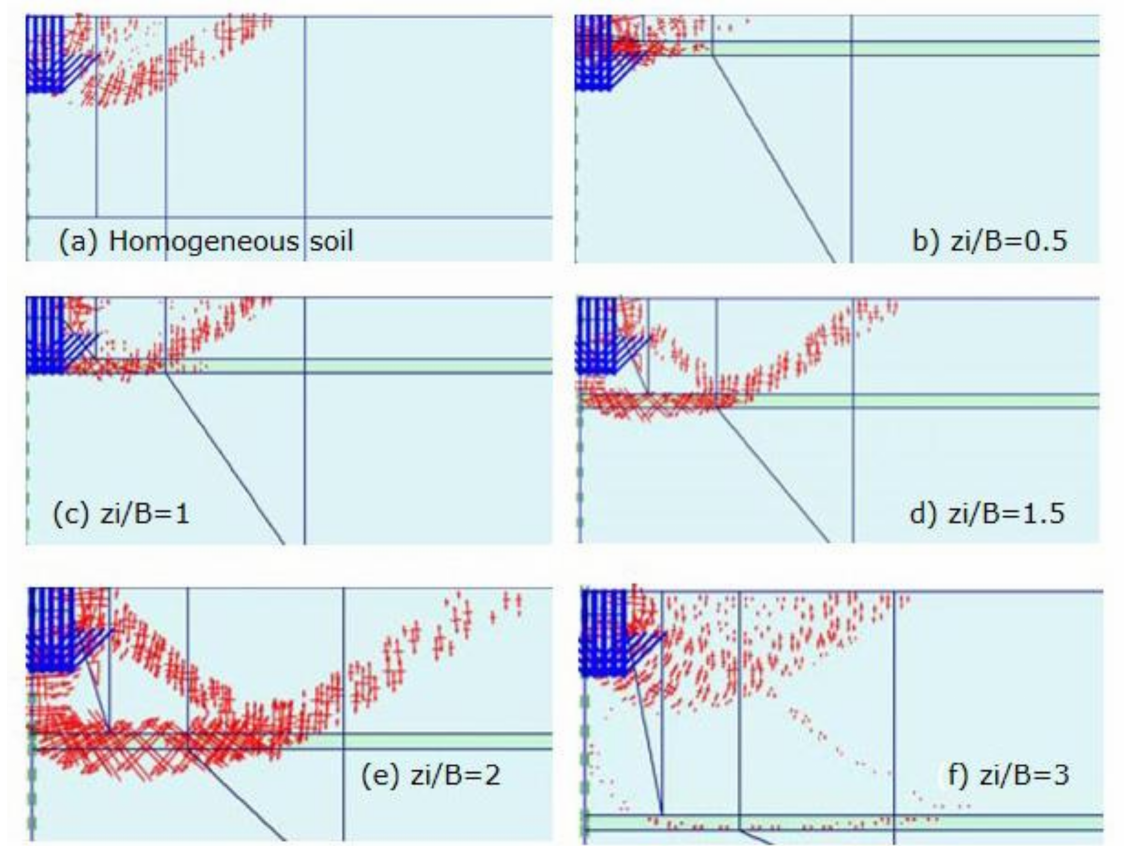
Figure 9. Incremental strains (principal directions) at failure for ϕ (cid:48) 1 = 40 ◦ , ψ (cid:48) 1 = 2/3 ϕ (cid:48) 1 = 26.7 ◦ (sand), ϕ (cid:48) 2 = 15 ◦ , ψ (cid:48) 2 = 0 (weak layer), as a function of the relative depth z i /B of the weak layer (B = 1